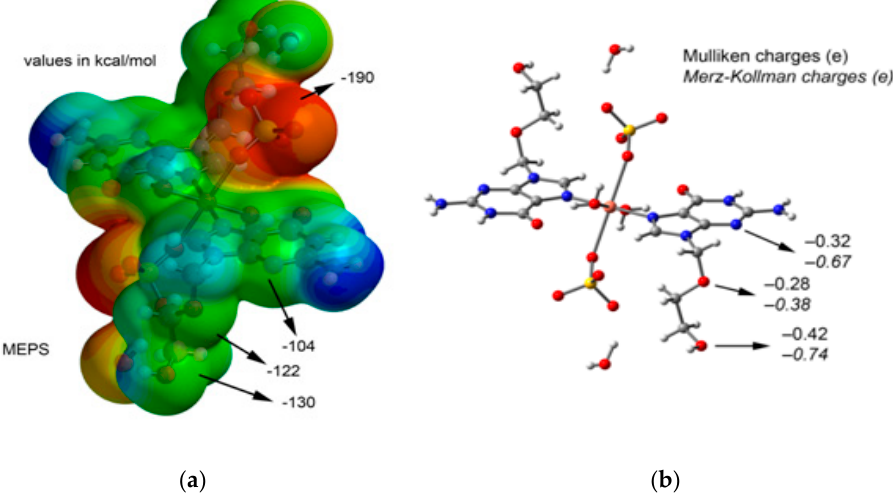
Figure 3. Compound 1 : ( a ) molecular electrostatic potential surface (MEPS). The values at selected points of the surface are indicated. Color code: from red to blue, with red being the most negative and blue the most positive values. ( b ) Mulliken and Merz-Kollman charges obtained at the BP86-D3/def2-TZVP level of theory.